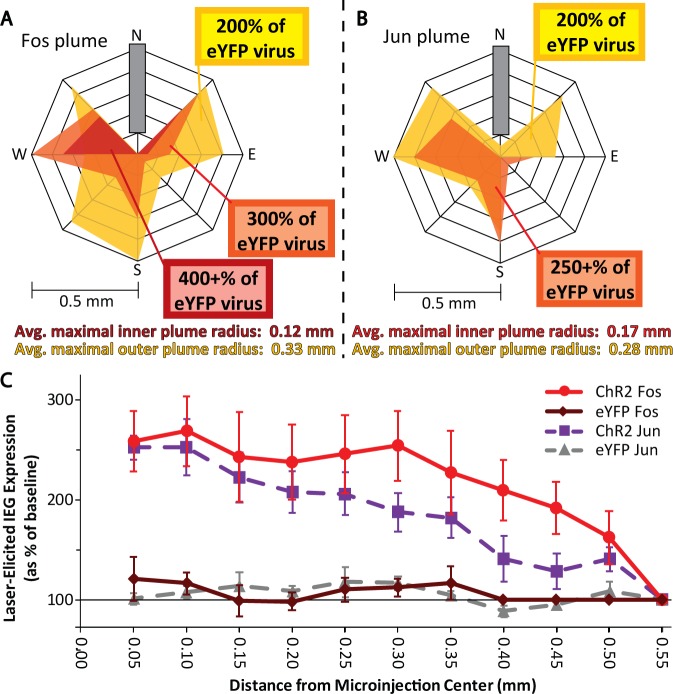
Fos and Jun plume metrics.A: Calculated average Fos plume. B: Calculated average Jun plume. C: Distance of elevated Fos and Jun expression relative to brains with inactive virus.